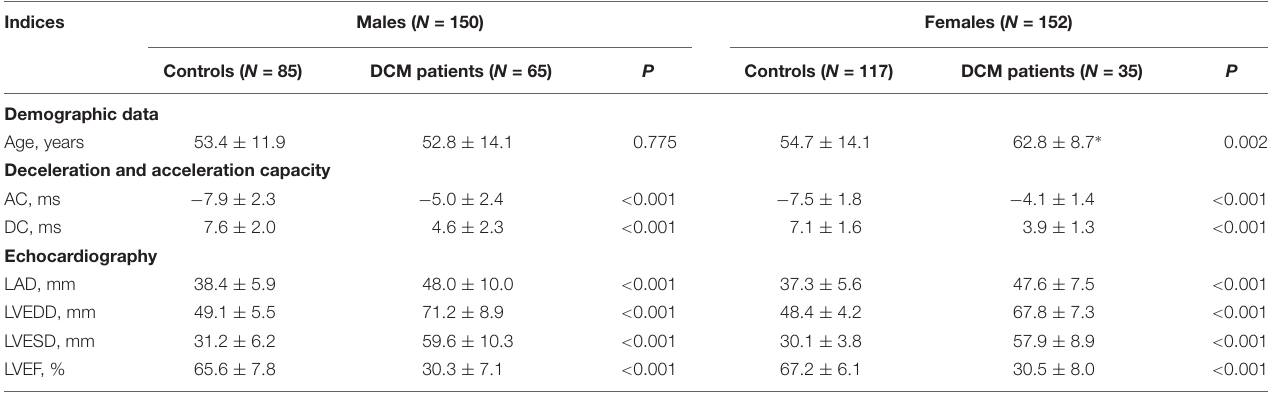
TABLE 1 | Differences between DCM patients and